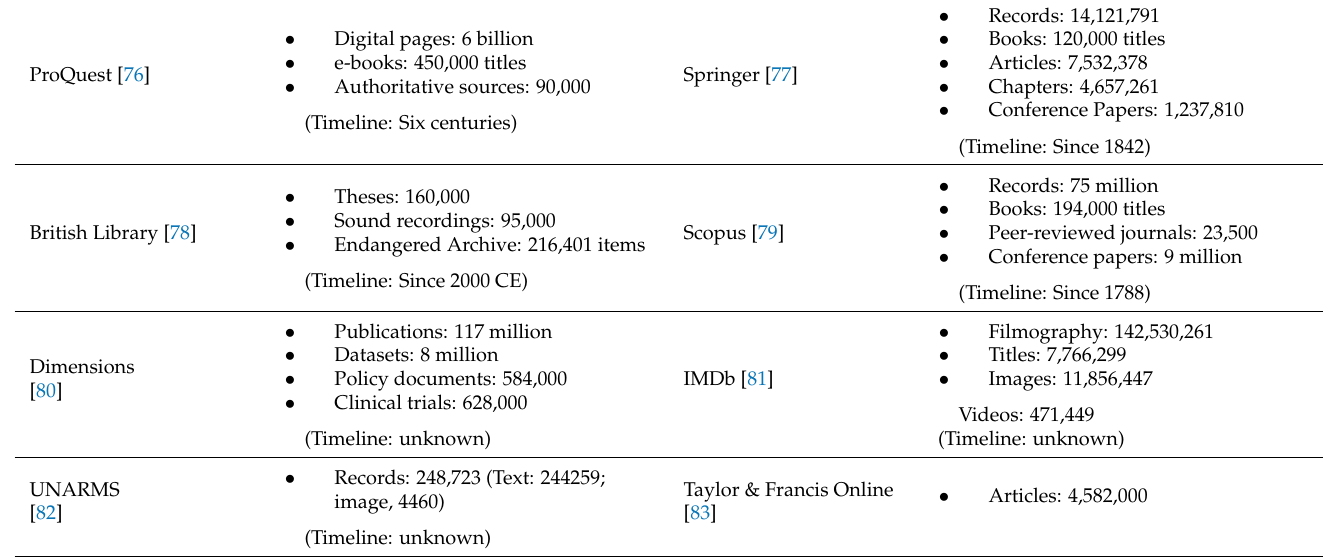
Table 4. Selected large global databases recording digital